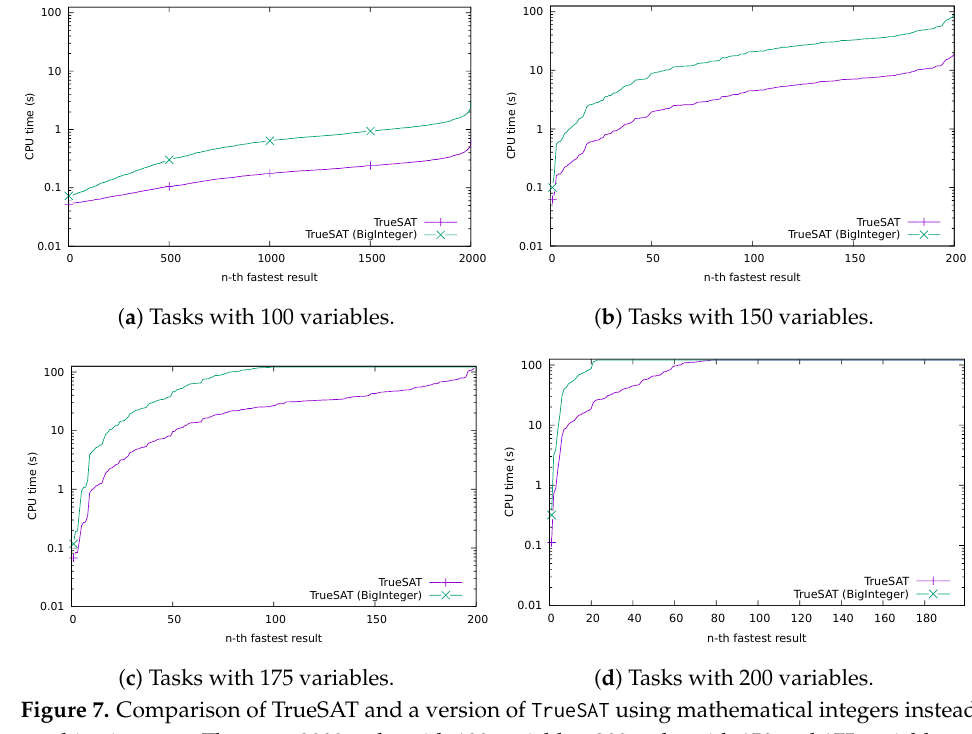
Figure 7. Comparison of TrueSAT and a version of TrueSAT using mathematical integers instead of machine integers. There are 2000 tasks with 100 variables, 200 tasks with 150 and 175 variables each, and 199 tasks with 200 variables. We plot the running time taken by the n -th fastest result for each solver. The y axis uses a logarithmic